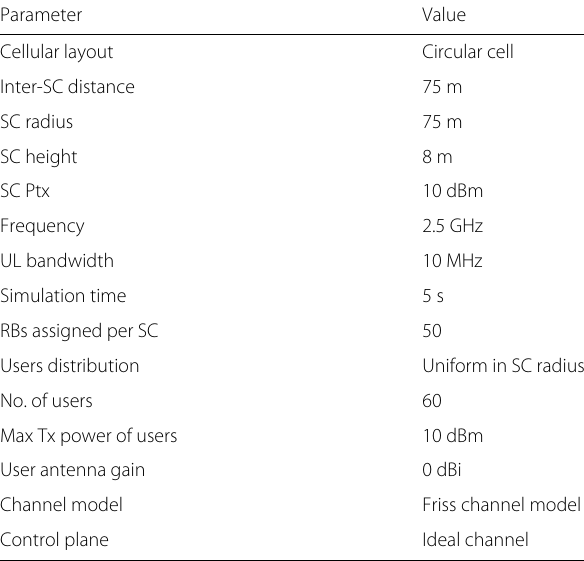
Table 2 Simulation system parameters Parameter